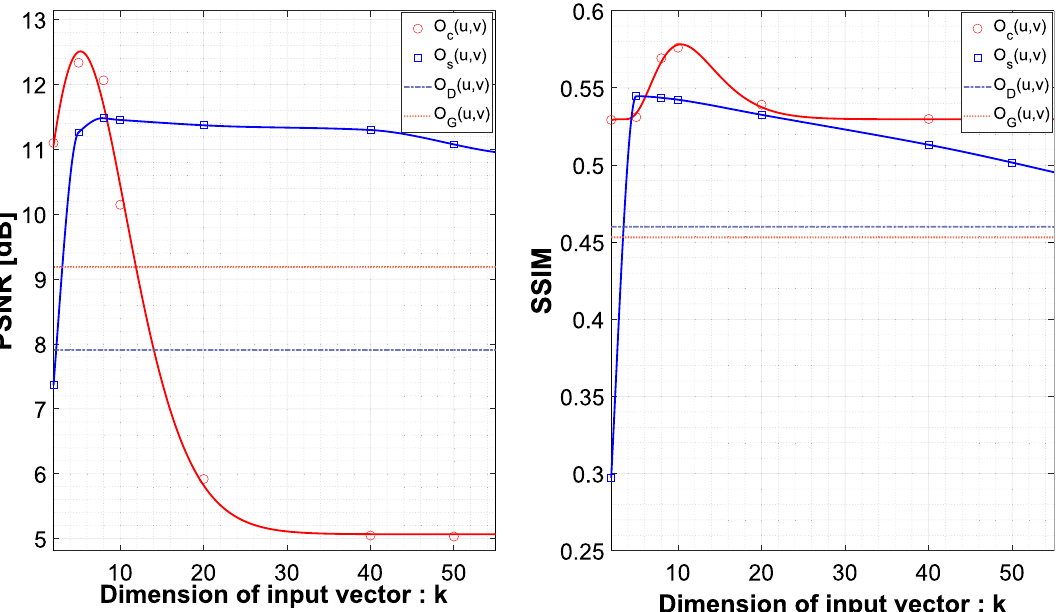
Figure 4. The graphs respectively show the PSNR change and SSIM change according to the size of the input vector. The experiment is demonstrated for 7 dimensions: { 2, 5, 8, 10, 20, 40, 50 } . As a comparison group, single- photon imaging O D ( u , v ) and quantum imaging O G ( u , v ) are indicated repectively by blue and red dashed lines. The single-photon imaging O s ( u , v ) and quantum imaging O c ( u , v ) with PSSVM applied to each are respectively indicated by blue squares and red circles.